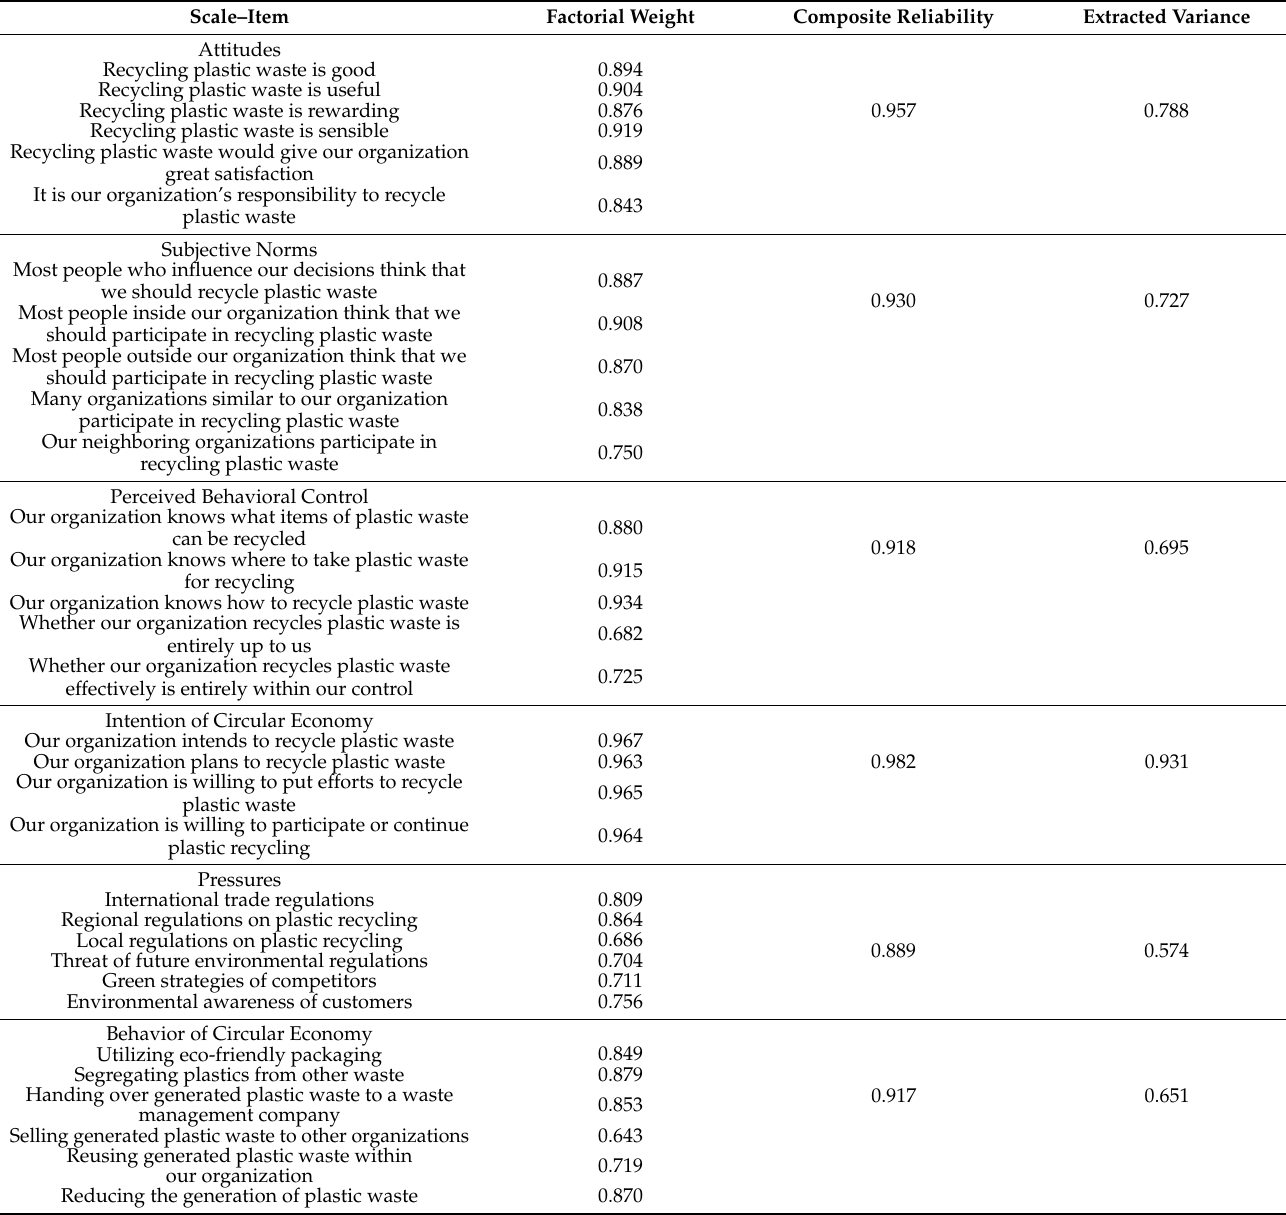
Table 1. Construct validity of the items of the scales using Structural Equations of Variance using Partial Least Squares.